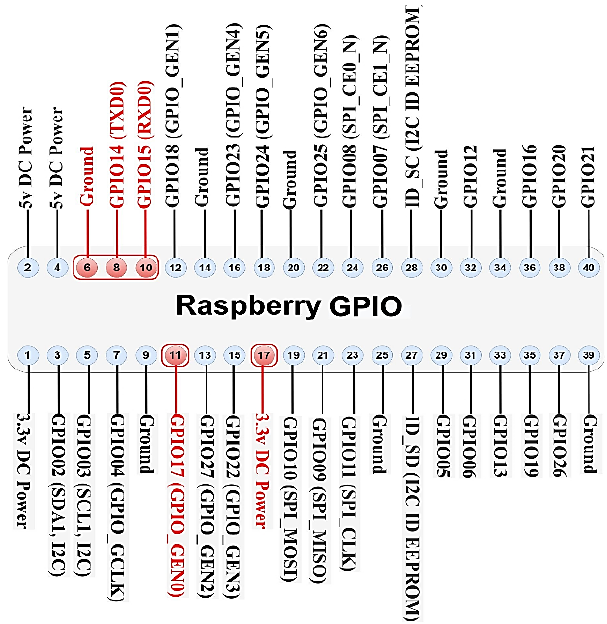
Figure 19. GPIO used by the module .